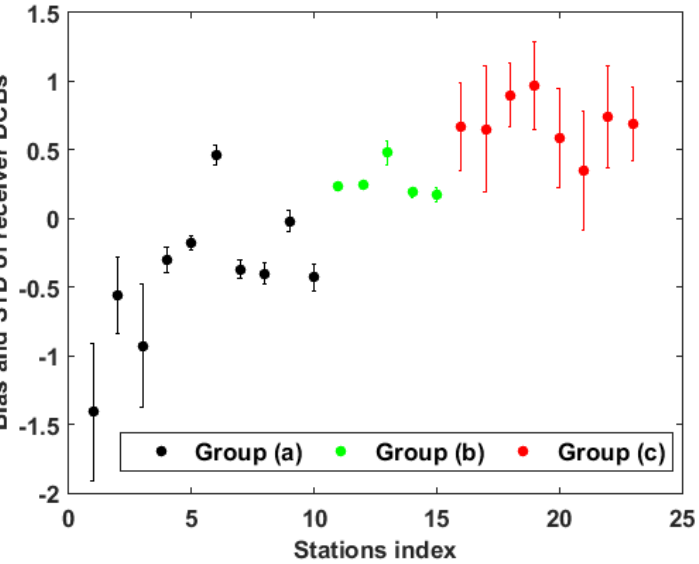
Figure 14. Mean differences and STDs of receiver C2I-C6I DCB estimates between BDS2+BDS3 and BDS2-only solutions for the TRIMBLE NETR9 receiver. Table 9. Consistency of receiver DCBs between BDS2-only and BDS2+BDS3 solutions for the TRIMBLE NETR9 receiver (unit: ns).